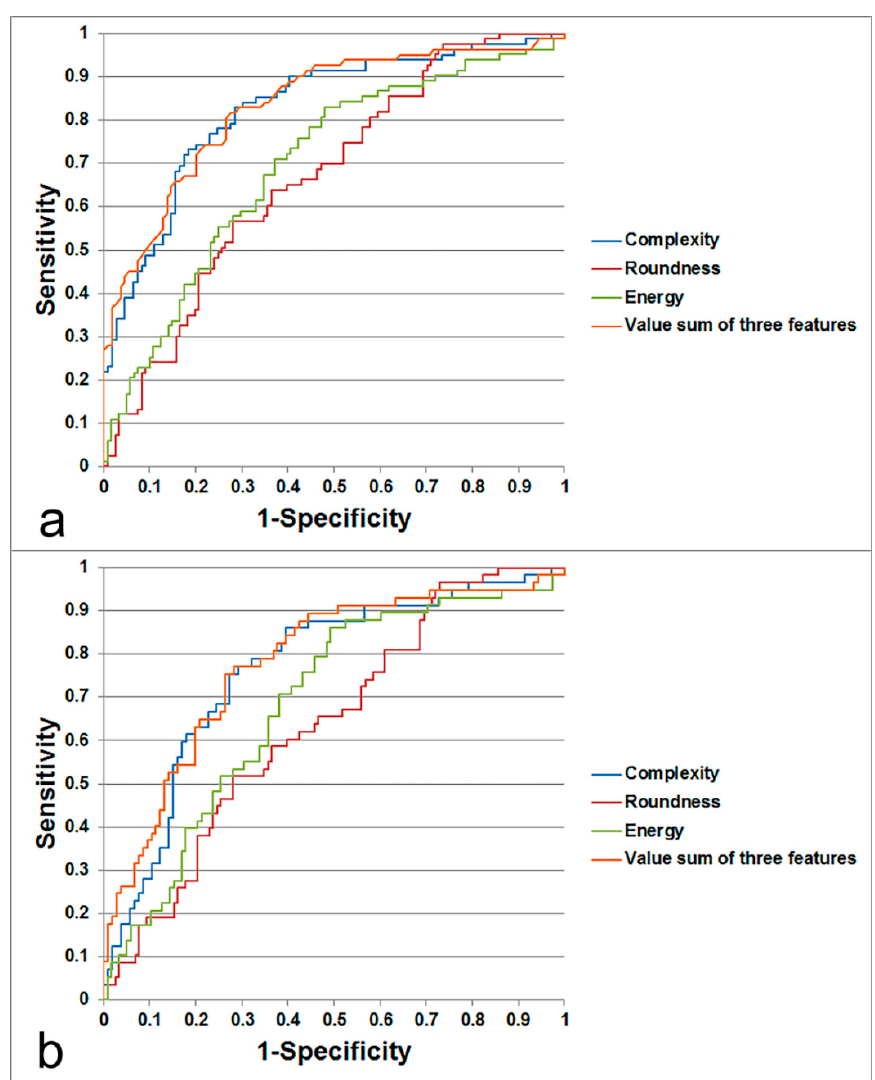
Figure 4. Receiver operating characteristic curves of texture features (complexity, energy and roundness) and the sum of all three features in all-sized lymph nodes ( a ) and subcentimeter-sized lymph nodes ( b ). The values of area under the curve (AUC) are presented in the Results.